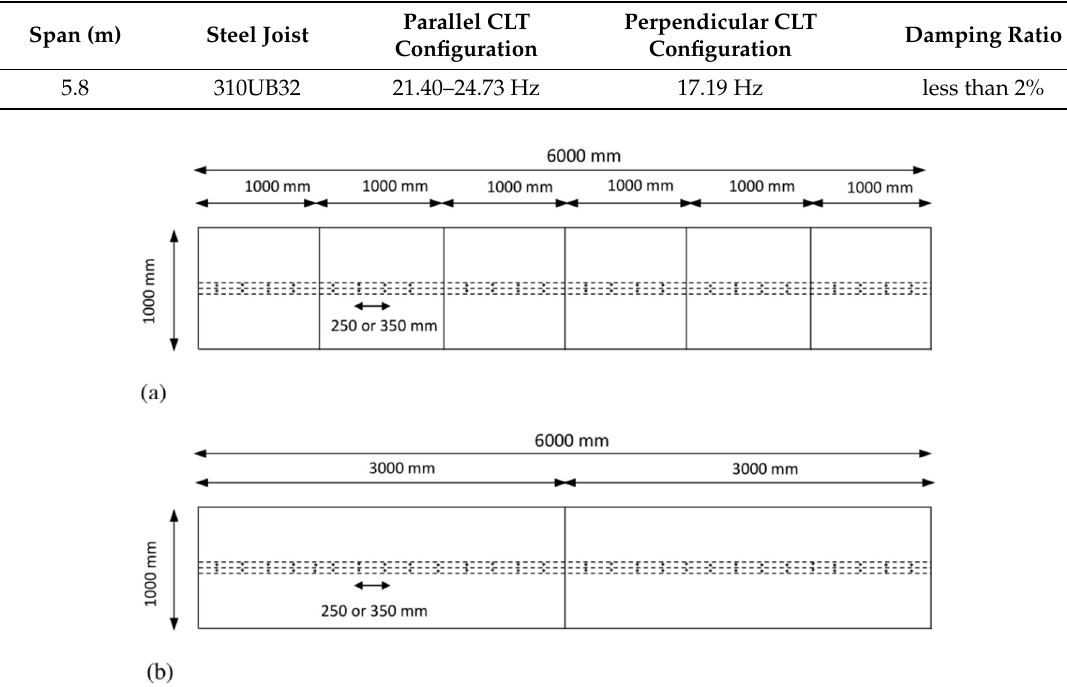
Figure 9. Schematic plan of steel-timber floors in ( a ) perpendicular and ( b ) parallel configuration by Chiniforush et al. [47].